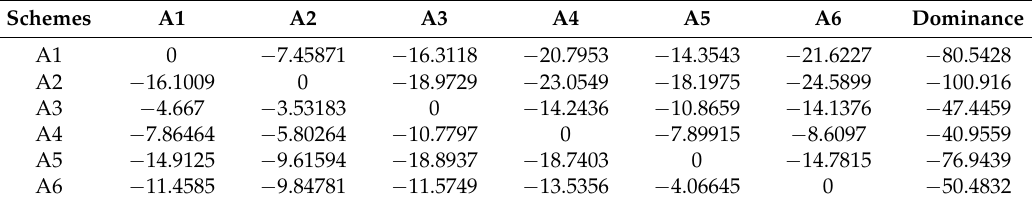
Table 7. Dominant Matrix of All Alternatives.